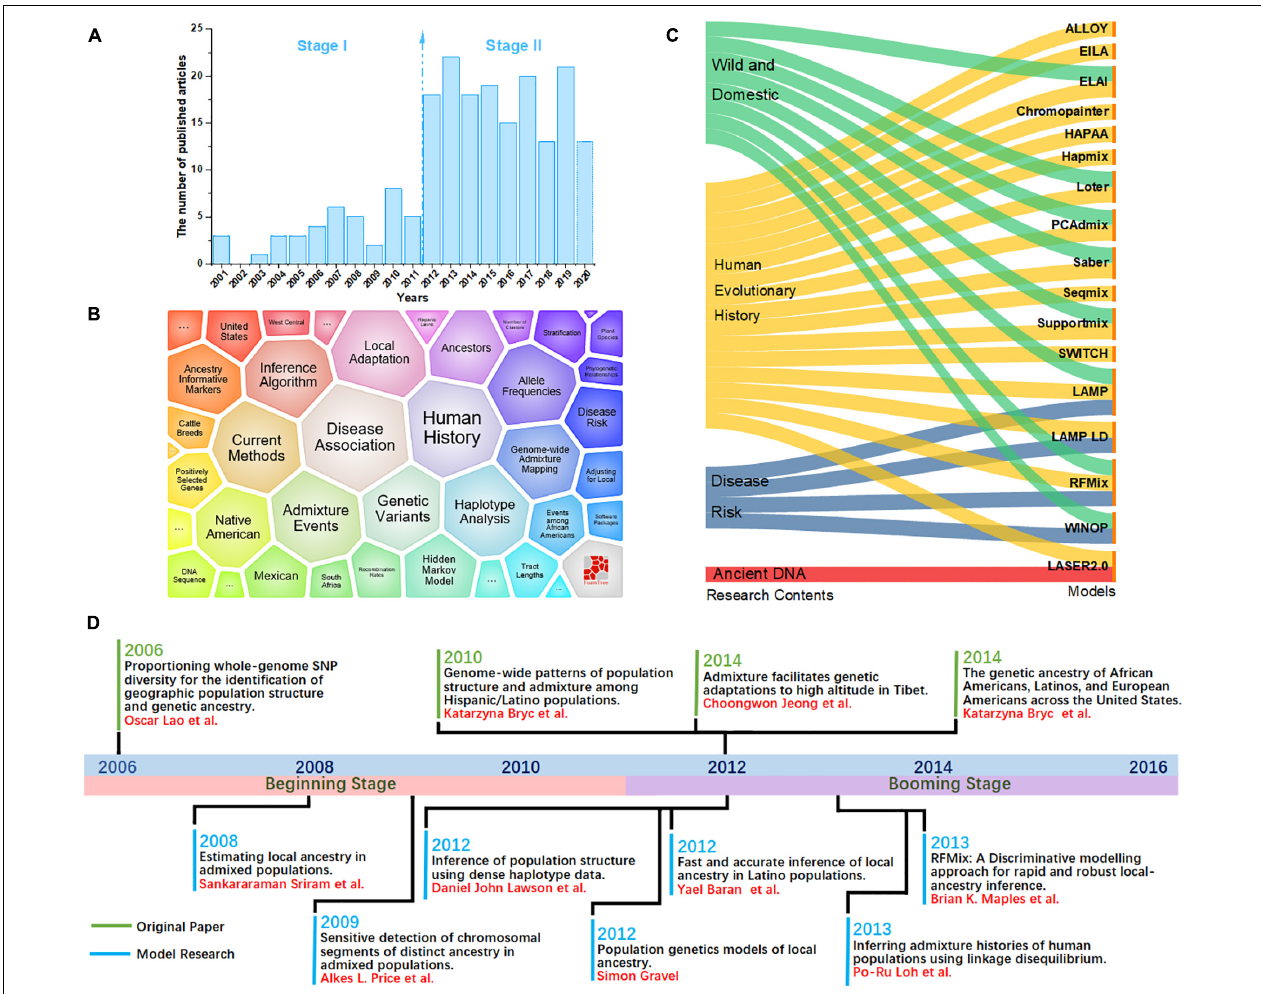
FIGURE 1 | (A) Number of local ancestry inference (LAI) publications from 2000 to 2020. (B) A visual survey of the major topics on LAI by the Carrot II system. (C) Distribution of models across the top four research fields including wild domestication, history of human evolution, disease risk, and ancient DNA. (D) Timeline illustrating the development of